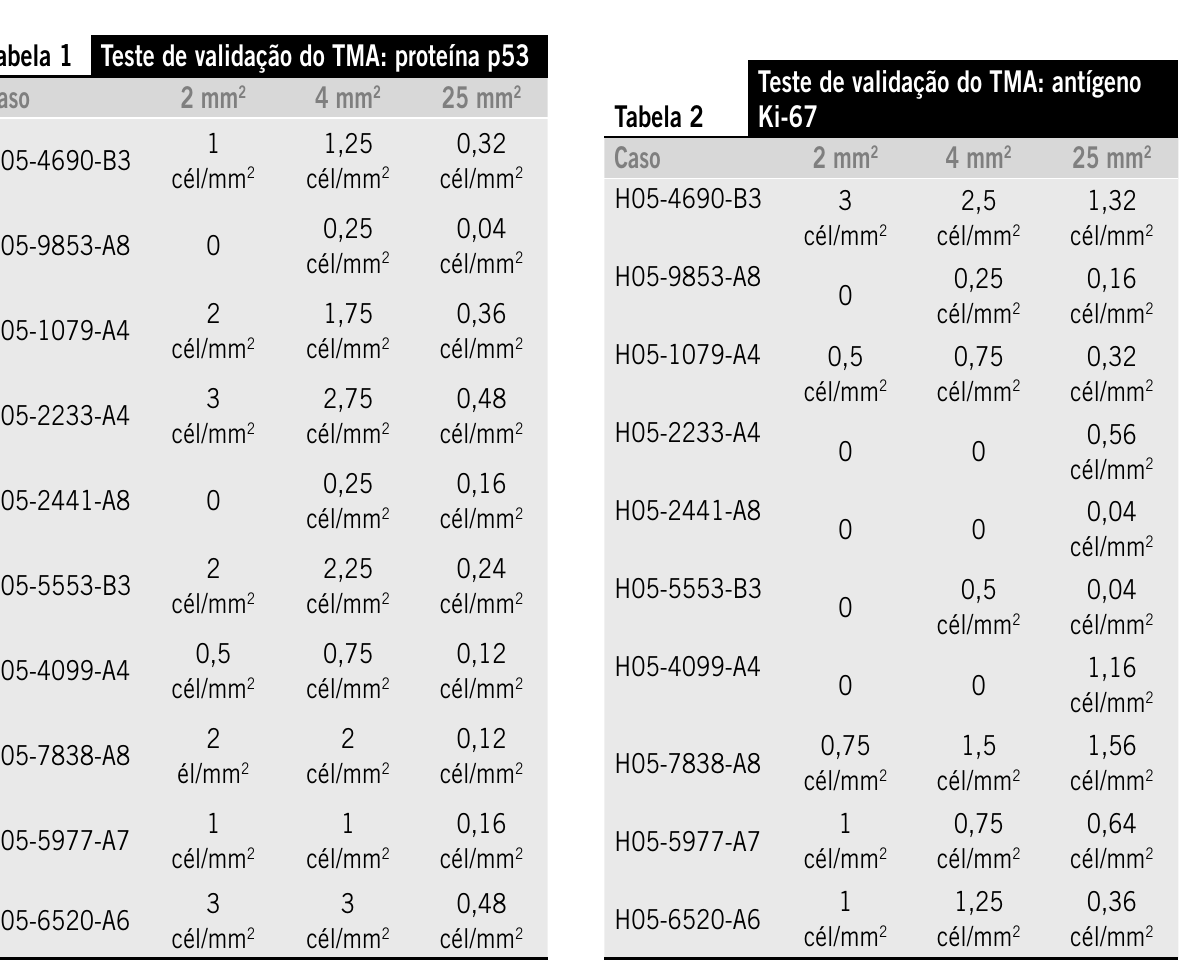
Figura 4 – Teste de validação do TMA: proteína p53 Teste t pareado TMA: tissue microarray